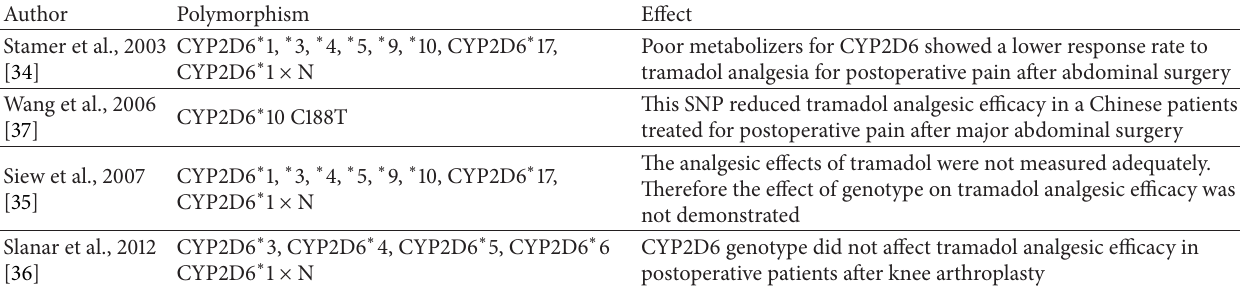
Table 3: Prospective studies providing evidence on the impact of polymorphisms of CYP2D6 on the analgesic efficacy of